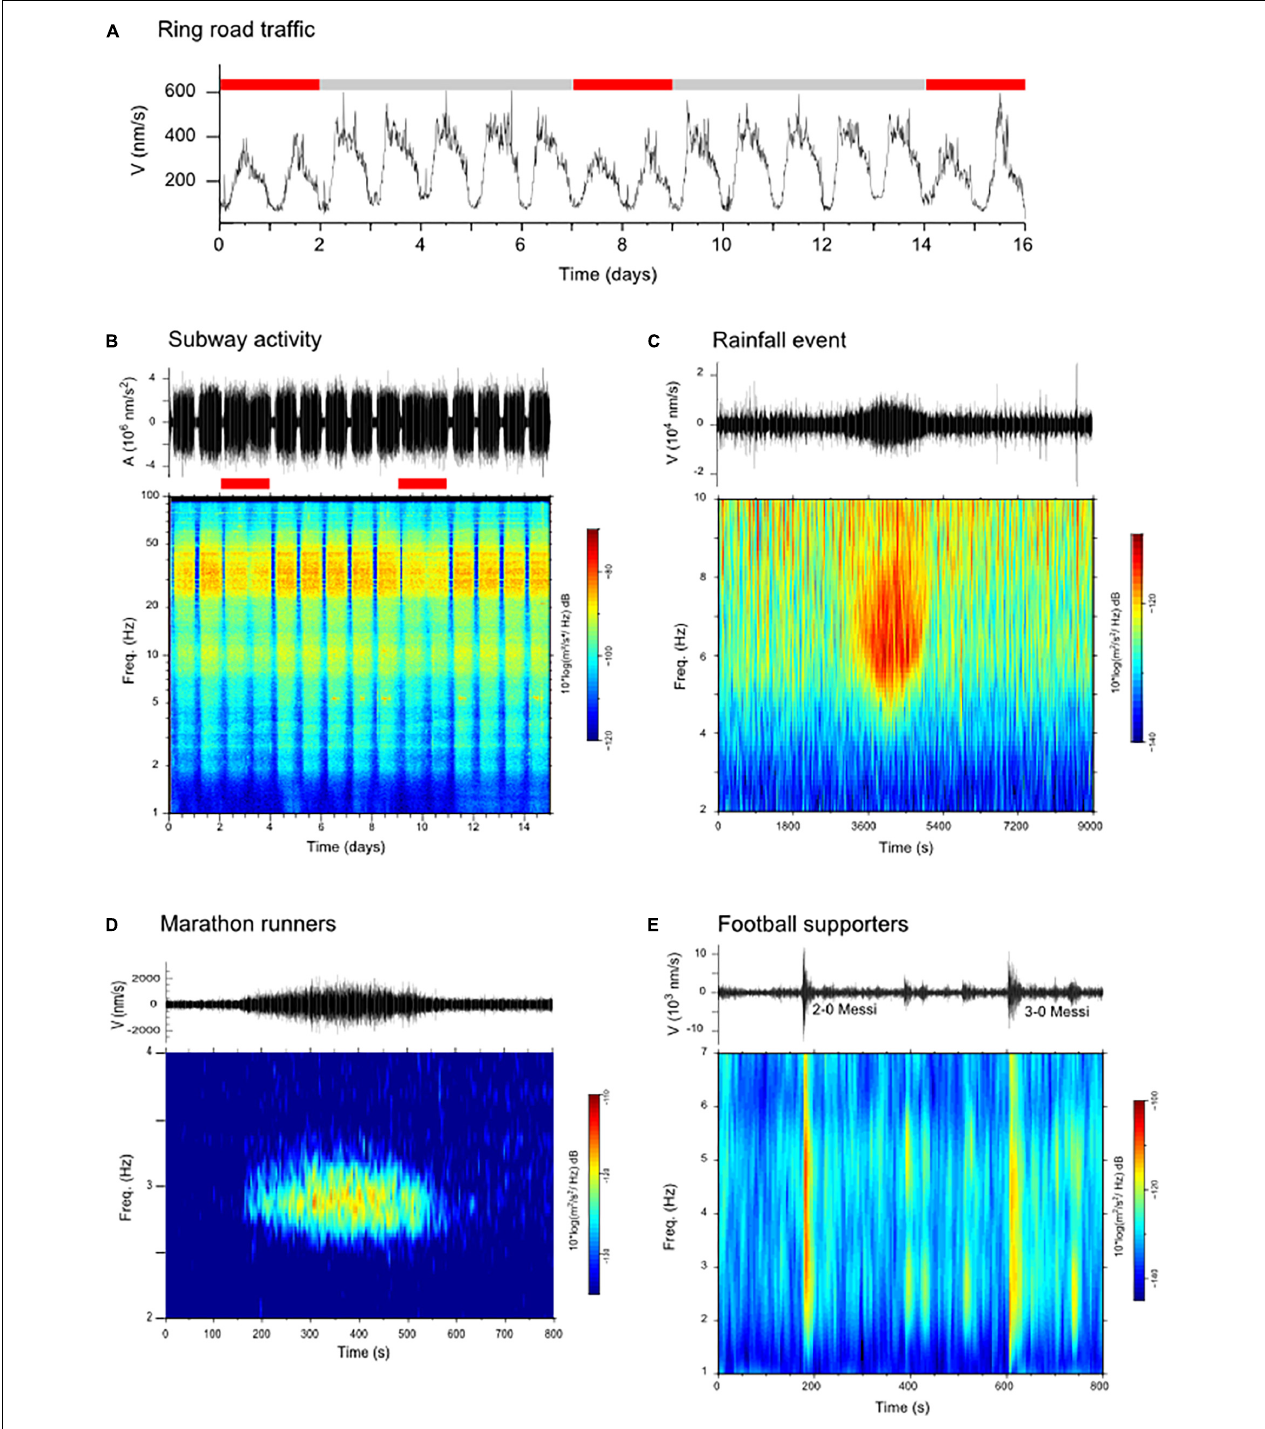
FIGURE 1 | Examples of non-tectonic seismic signals recorded in urban environments. (A) Envelope of the vertical seismic component at a site close to the Barcelona ring road, filtered between 4 and 12 Hz and decimated to six samples per hour. Red and gray bars show week-end and business days (18/2/2017–6/3/2017). (B) Vertical component and spectrogram for the CA.BAIN accelerometric station, installed in central Barcelona, showing the activity of the subway system. Week-end days are marked by red bars (1/11/2018–16/11/2018). (C) Seismic data (filtered between 4 and 8 Hz) and spectrogram recorded at CA.ICJA during a heavy rainfall event the 15/11/2018. (D) Seismic record (filtered between 2.4 and 3.4 Hz) and spectrogram of the passage of the Barcelona Marathon runners near the CA.ICJA seismic station (11/3/2018). (E) Seismic record at the CA.ICJA station during the FCB-Liverpool Champions League match (1/5/2019), showing the shaking generated by the supporters celebration of Messi’s goals.